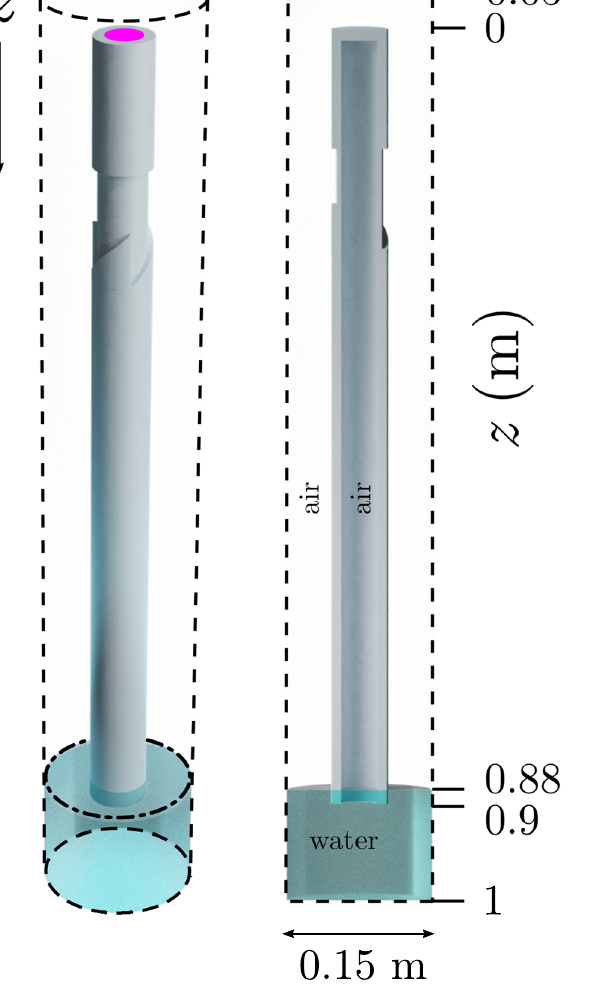
Fig. 7 FEM Simulation domain. Fully coupled acousto-elastic equations are solved for between the aluminium pipe and air, the pipe and the water, and the air and water. The boundary load applied at z = 0 to top surface of the pipe represents the excitation from the piezoelectric disc, shown as magenta circle of diameter 35 mm. Dashed lines correspond to cylindrical radiation